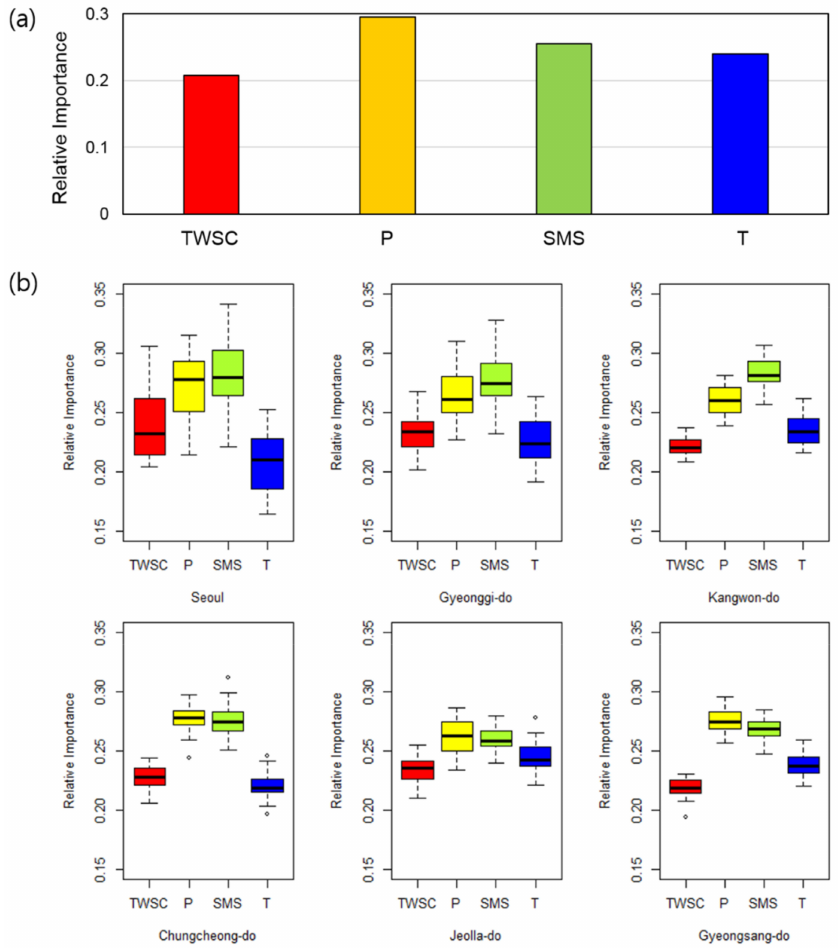
Figure 7. Relative importance of input variables; ( a ) for entire country; ( b ) for representative administrative